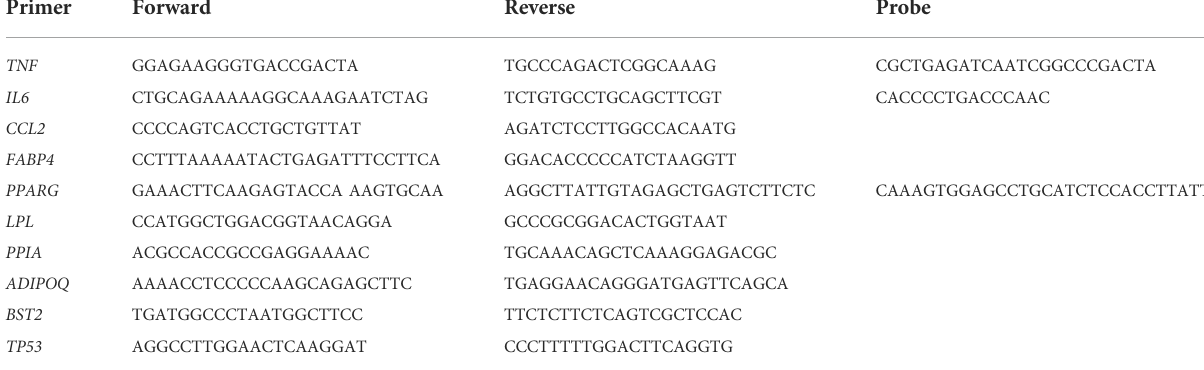
TABLE 2 qPCR primer sequences.